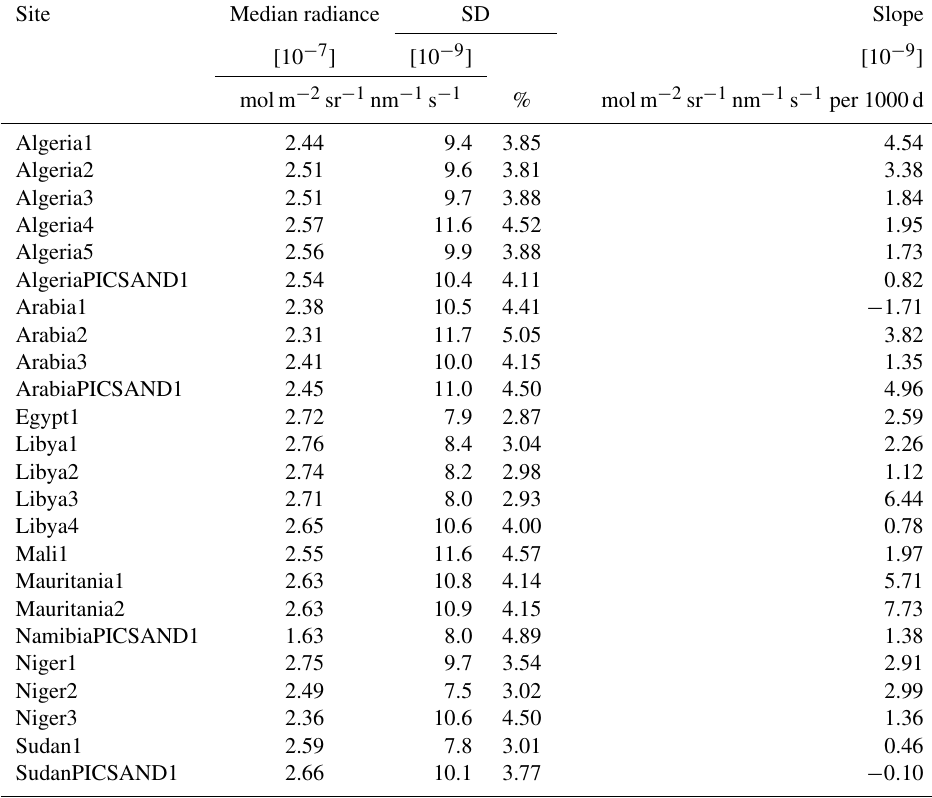
Table 3. Median radiance, standard deviation (both absolute and relative) and slope of a linear fit for the full